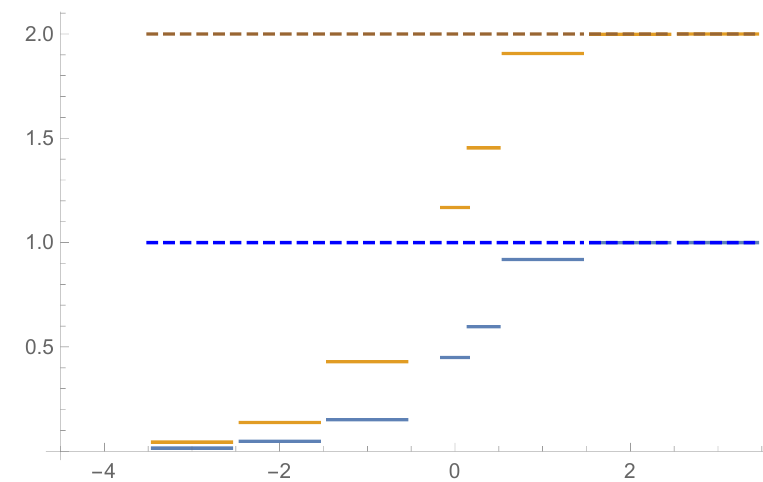
Figure 5. Kaluza-Klein spectrum M 2 ( (cid:2) H 0 L 2 ) with d = 3 for a non-trivial warp factor (plain N lines), compared to the standard spectrum for a constant warp factor (dashed lines), depending on the parameter value log ( L=l s ). The bottom (blue) lines correspond to a -modes with N = 1, the 10 p upper lines to s -modes with N = 2, as given in table